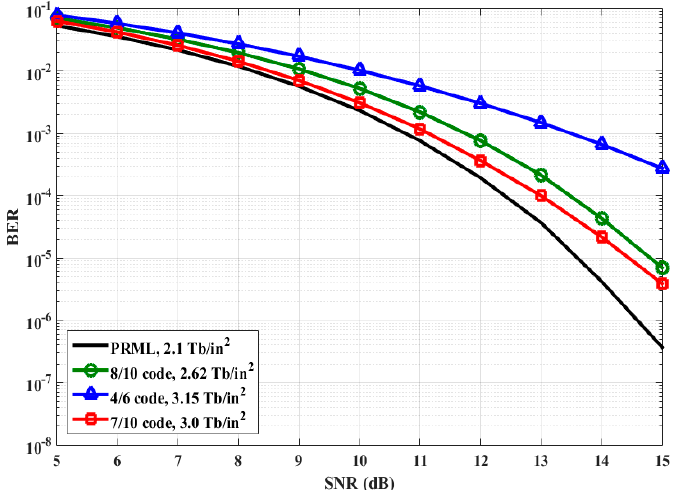
Figure 7. BER performance according to modulation coding scheme at UD = 2.1 Tb / in 2 .